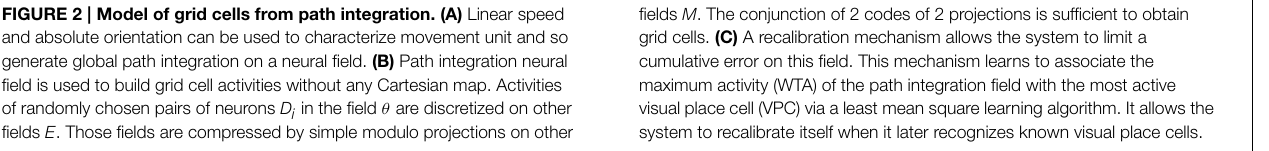
FIGURE 2 | Model of grid cells from path integration. (A) Linear speed and absolute orientation can be used to characterize movement unit and so generate global path integration on a neural field. (B) Path integration neural field is used to build grid cell activities without any Cartesian map. Activities of randomly chosen pairs of neurons D i in the field θ are discretized on other fields E . Those fields are compressed by simple modulo projections on other